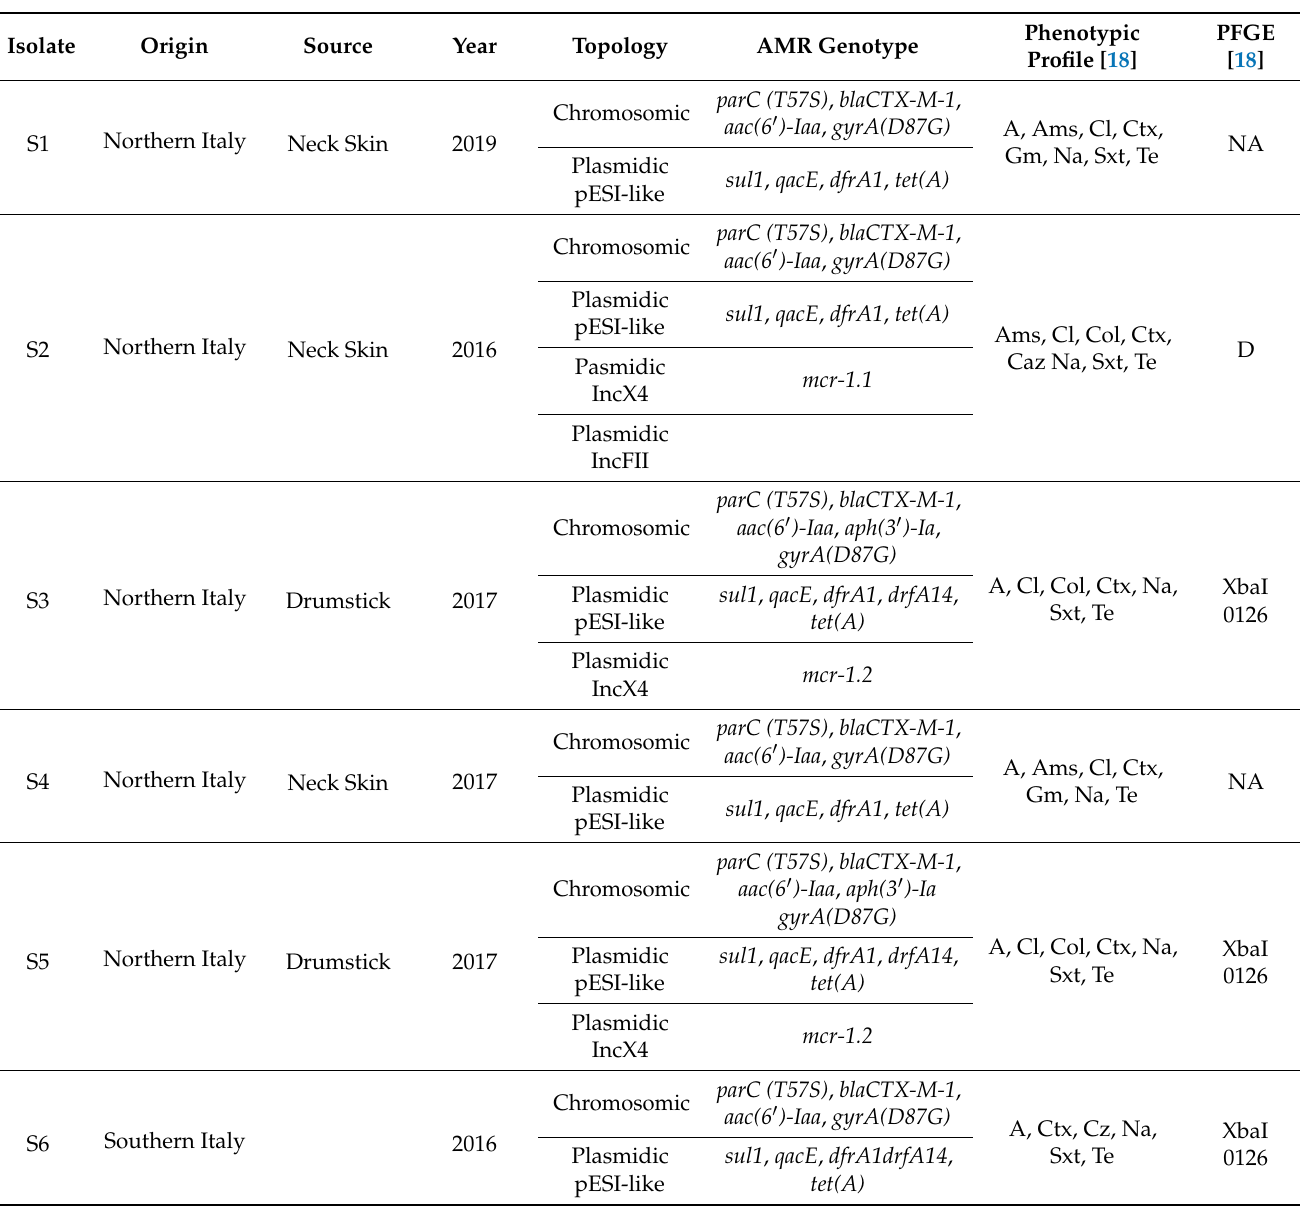
Table 1. Genotypic and phenotypic profiles of the six S . Infantis